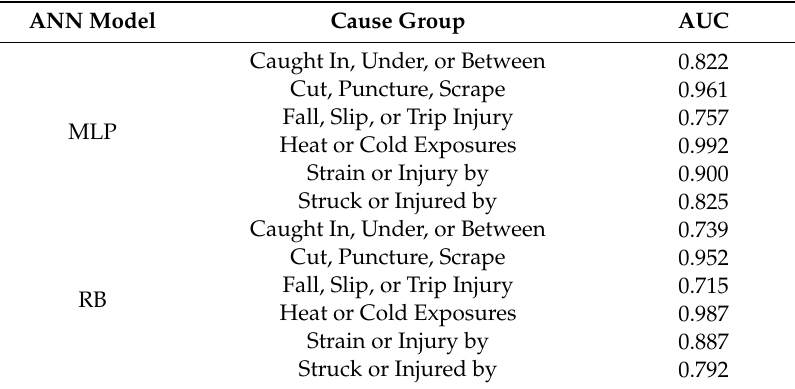
Table 6. Comparison of Area under the Curve for MLP and RBF